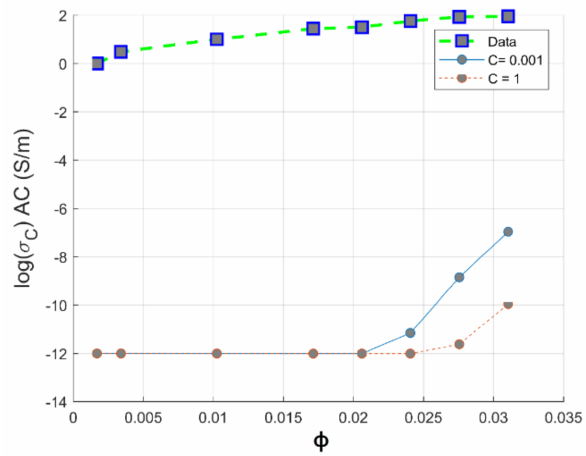
Figure 13. Theoretical and experimental plots of conductivity against volume fraction of CNTs based on the Sohi model for PC-CNT conductive composite system.